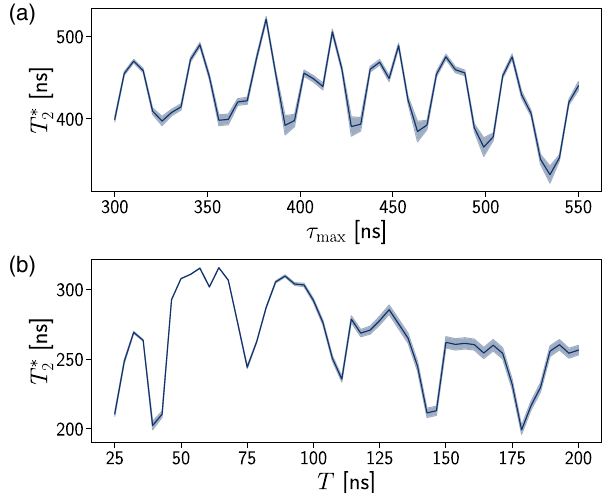
FIG. 14. Feedback performance for a single-species unitary algorithm. (a),(b) Simulated T (cid:4) 2 versus maximum sensing time τ and actuation time T , respectively. The evolution during the max feedback algorithm is entirely unitary, except for the explicit dissipative reset step. Here we use the model parameters found in Appendix E 6, but we only simulate a single nuclear species with Zeeman frequency ω n ¼ 29 MHz. Shaded regions represent the 68% confidence